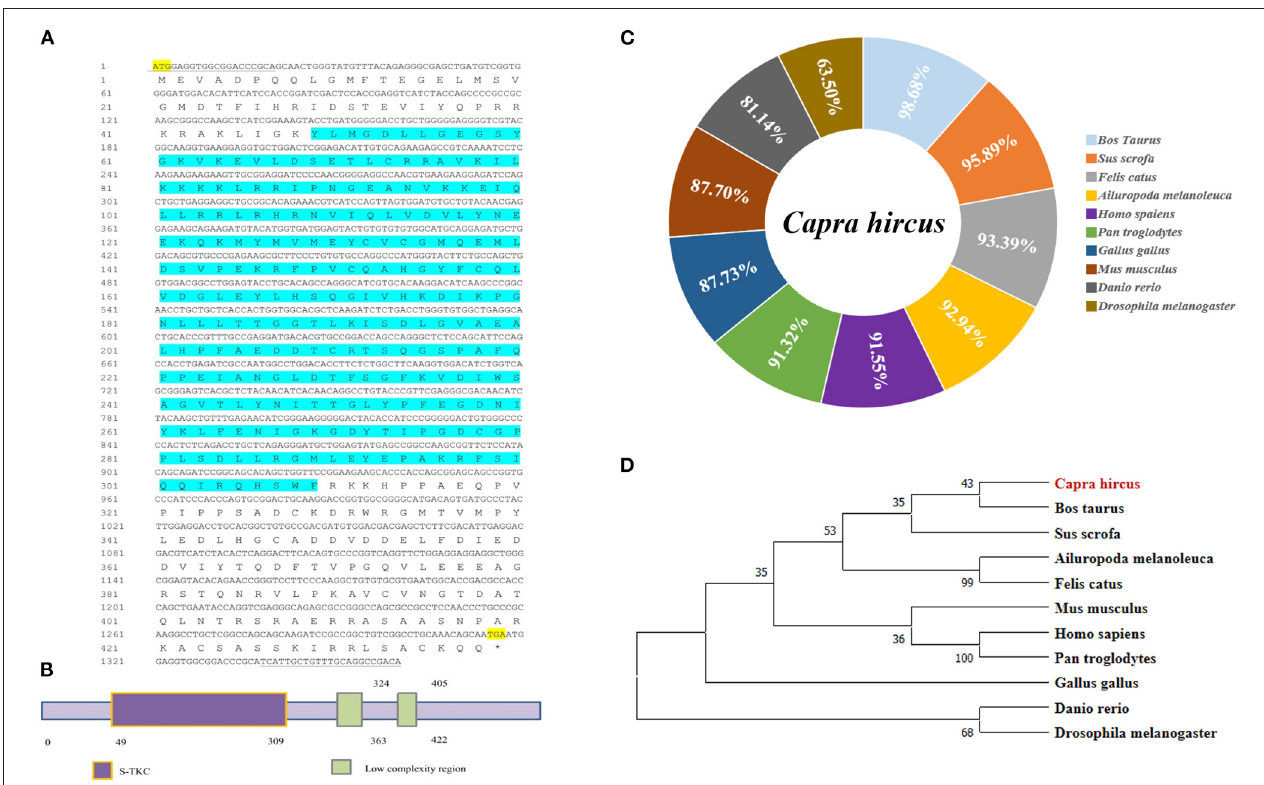
FIGURE 1 | The cloning of goat LKB1 gene and its alignment analysis among species. (A) The nucleotide sequence and the translated amino acid sequence of goat LKB1 ( * Represents the stop codon). (B) Prediction of the biological function of LKB1 amino acid sequence. (C) The amino acid sequence identity was analyzed by NCBI blast for LKB1 protein between goat and other mammalian species retrieved from GenBank. Capra hircus (MW664927), Sus scrofa (XP_020939922.1), Ailuropoda melanoleuca (XP_002923557.1), Felis catus (XP_003981653.1), Homo sapiens (NP_000446.1), Pan troglodytes (XP_024206909.1), Gallus gallus (NP_001039298.1), Mus musculus (NP_035622.1), Bos taurus (XP_024850893.1), Danio rerio (NP_001017839.1), and Drosophila melanogaster (NP_001163606.1). (D) LKB1 amino acid sequence phylogenetic tree was constructed by ClustalX 1.83 and MEGA7.0. LKB1, liver kinase